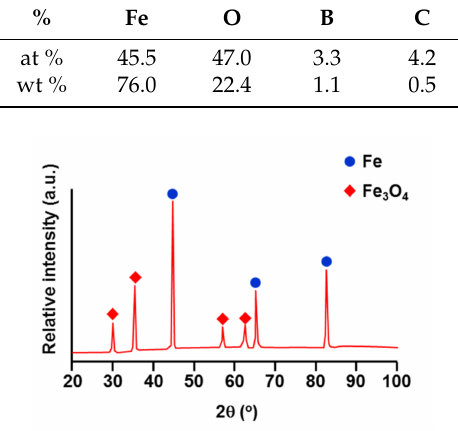
Figure 2. Result of XRD analysis for the oxide film formed on the surface of steel.